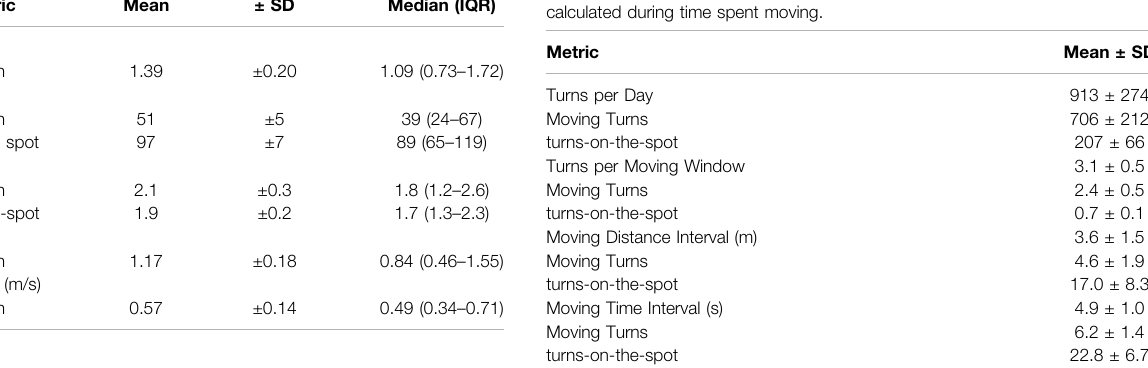
( Figure 4A ). The median angle for moving turns was 39.1 ± 4.2 ° , and 89.5 ± 8.1 ° for turns-on-the-spot. 90% of turning angles were smaller than 111.2 ± 19.0 ° among moving turns and 148.1 ± 7.6 ° for turns-on-the-spot ( Figure 4B ).